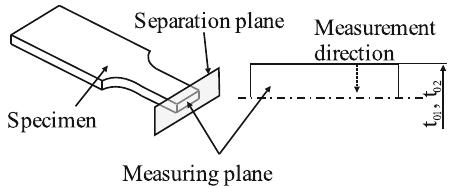
Fig. 7. Location of measuring points for the distribution of Vickers hardness along the